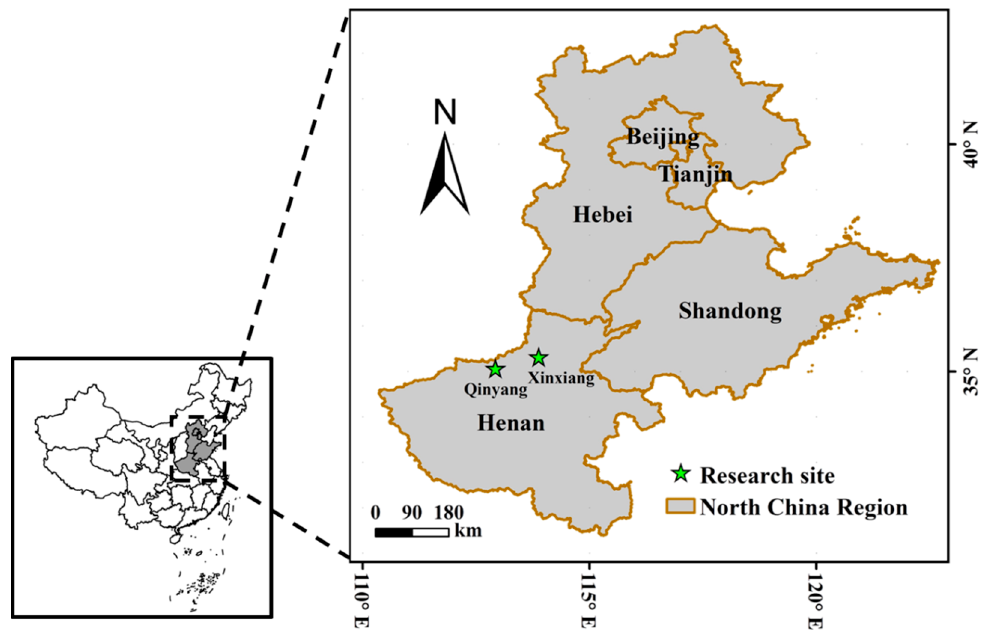
Figure 1. Location of North China Plain and the field experiment site. E: East longitude; N: North latitude. A popular winter wheat variety was sown at the rate of 180 kg · ha − 1 in the middle of October each year. Each plot was 3 m wide and 30 m long, the row space was 20 cm (15 rows in each plot), planted